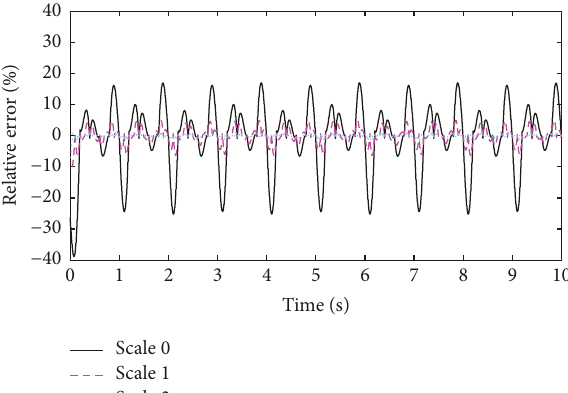
Figure 11: The reconstructed error in Case F1.